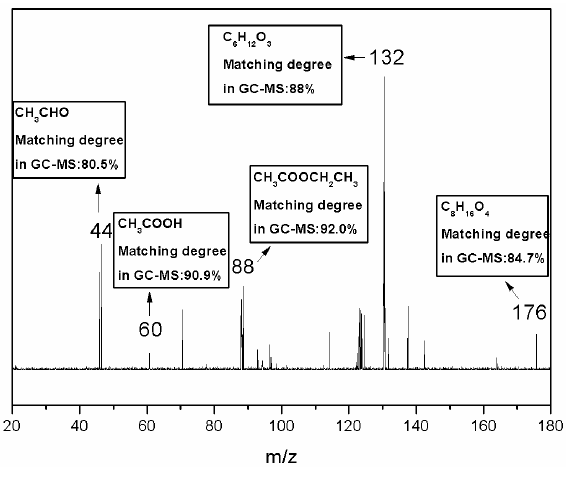
Figure 4. The comprehensive results of acetaldehyde in GC ‐ MS and LC ‐ MS.